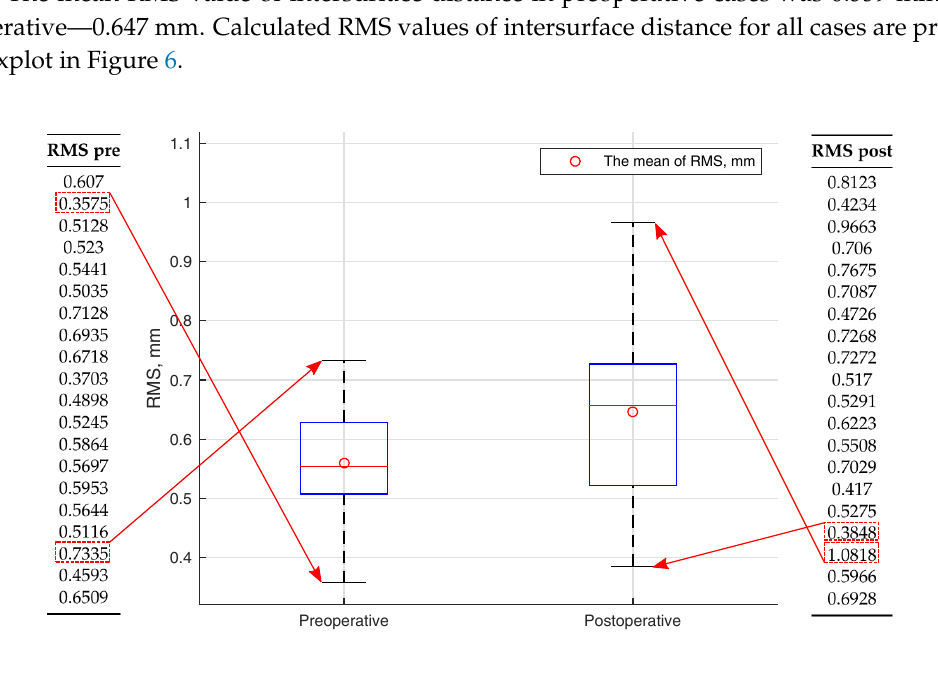
Figure 6. Distributions of RMS values of preoperative and postoperative segmentation